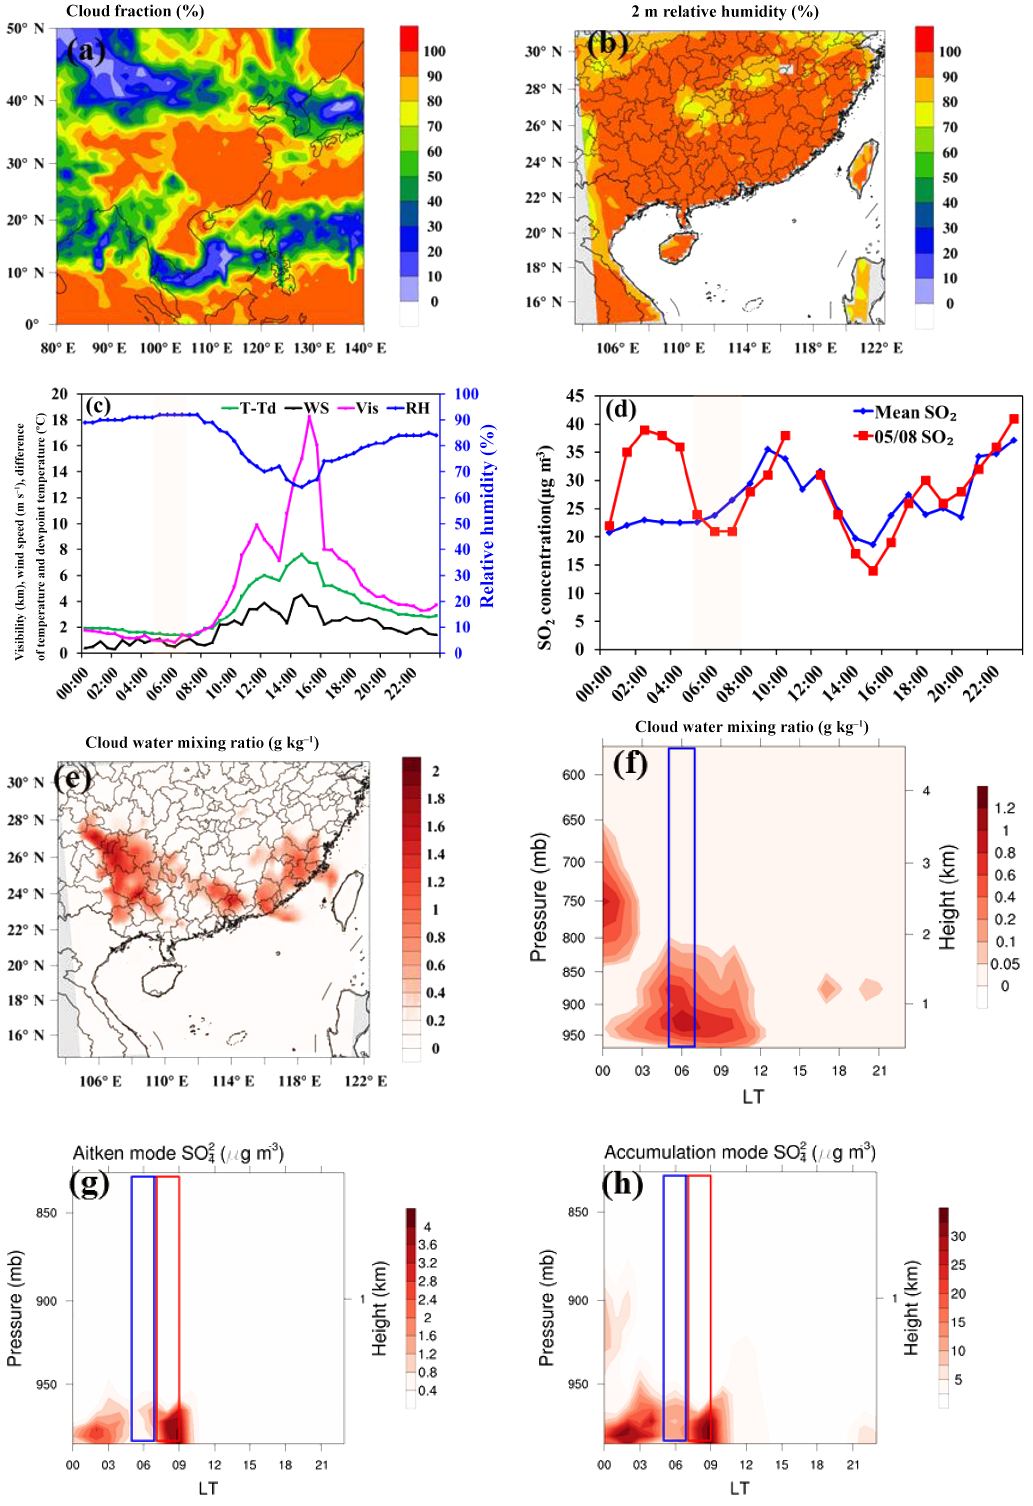
Figure 4. Case study on 8 May in GZ. (a) The cloud fraction over southern China. (b) Distribution of simulated average 2m relative humidity at 05:00–07:00 LT. (c) The time series of observational visibility, wind speed, relative humidity, and the depression of dew point (time resolution was 30min). (d) The time series of monitored mean SO 2 during 2009–2010 and SO 2 on 8 May. (e) Distribution of simulated average cloud. (f) The time–height distribution of simulated cloud water mixing ratio on 8 May. (g–h) The time–height of simulated Aitken and accumulation mode SO 2 − 4